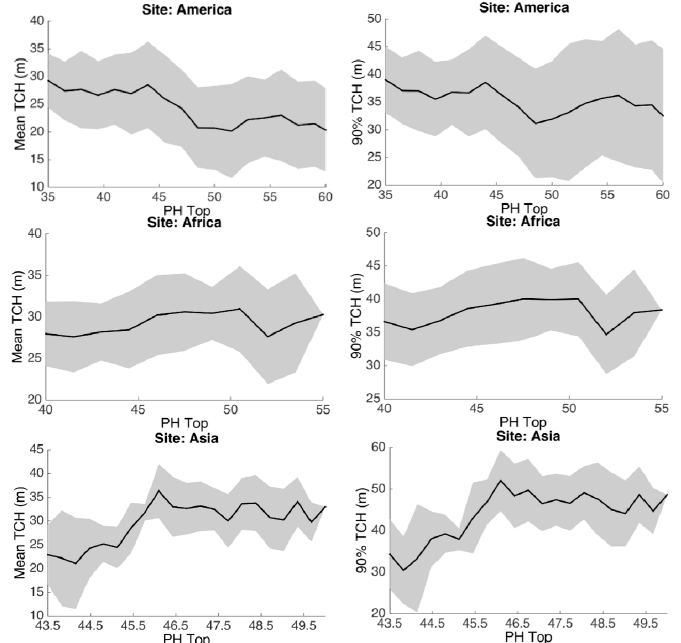
Figure 7. Tree height (TCH m and TCH 90 ) variations with soil pH values. The height metrics are binned into up to 20 groups along the pH value axis to get the mean and standard deviation.